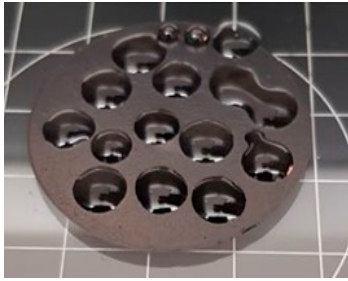
Figure 8. A BP with single drops of HPLC water applied through most of the surface.